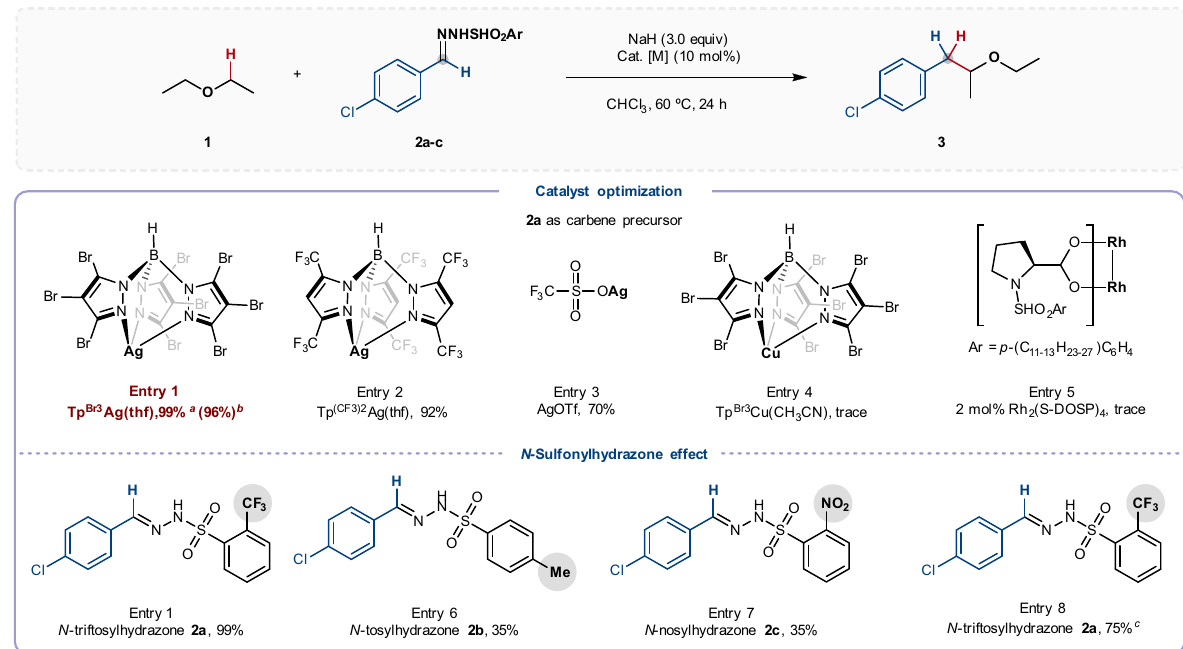
Fig. 2 Selected optimization of reaction conditions. Reaction conditions: N -Sulfonylhydrazone 1a – c (0.3 mmol), NaH (0.9 mmol, 3.0 equiv), catalyst (10 mol%), Et 2 O (1.0 mL), and CHCl 3 (5.0 mL), under argon at 60 °C for 24 h unless otherwise indicated. a Yields were determined by 1 H